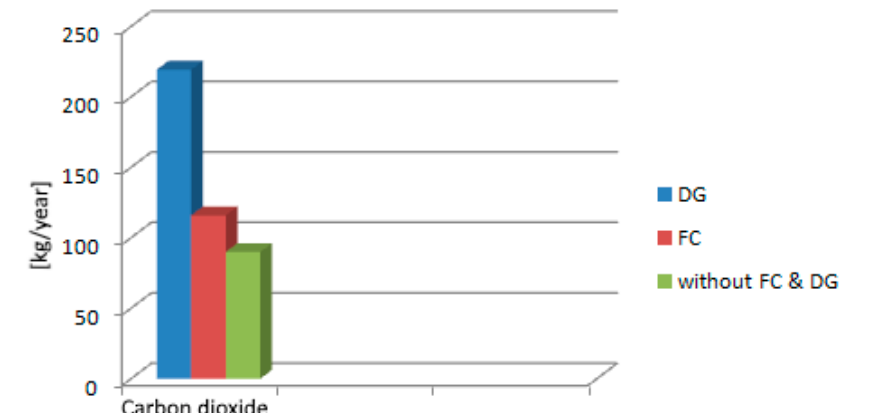
Figure 24. Comparison of pollutant emissions of the three cases using iHOGA.